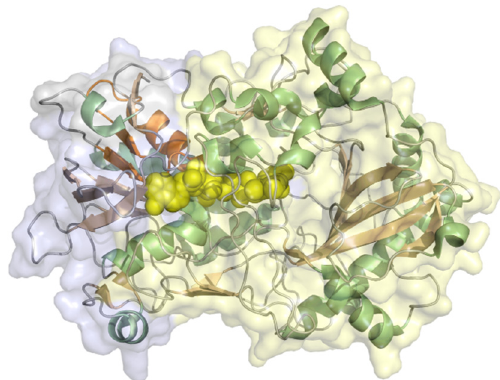
Figure 7. Crystal structure of Agaricus meleagris pyranose dehydrogenase (PDB: 4H7U) with the FAD cofactor (yellow spheres) buried inside the protein shell. The FAD-binding- and substrate-binding subunits are colored light blue and light yellow, respectively. The GMC-oxidoreductase family characteristic dinucleotide binding βαβ -motif (Rossmann-fold) is highlighted in orange.